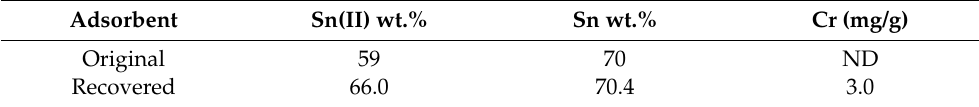
Table 10. Chemical analysis of original and recovered adsorbent. Adsorbent Sn(II) wt.% Sn wt.% Original